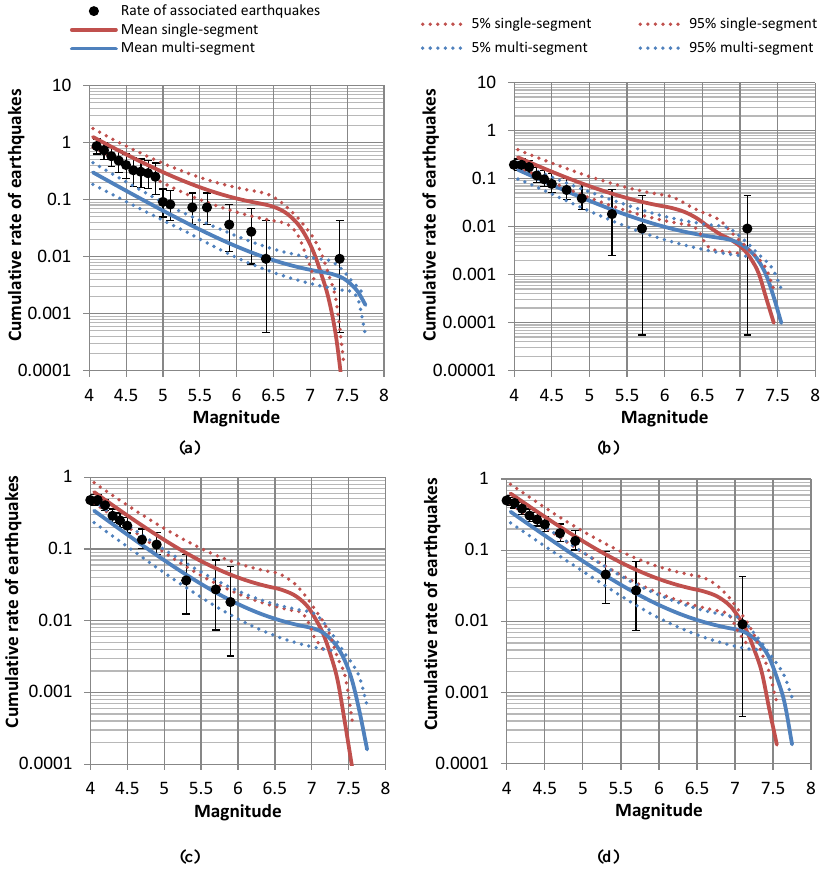
Figure 6. Mean and fractals of the single-segment and multi-segment rupture scenarios with the cumulative rate of earthquakes associated with the rupture system for (a) Izmit, (b) Düzce, (c) central Marmara, and (d) Ganos/Saros rupture systems. Solid lines are the mean rates and the dashed lines show the 5 and 95% rates for each rupture